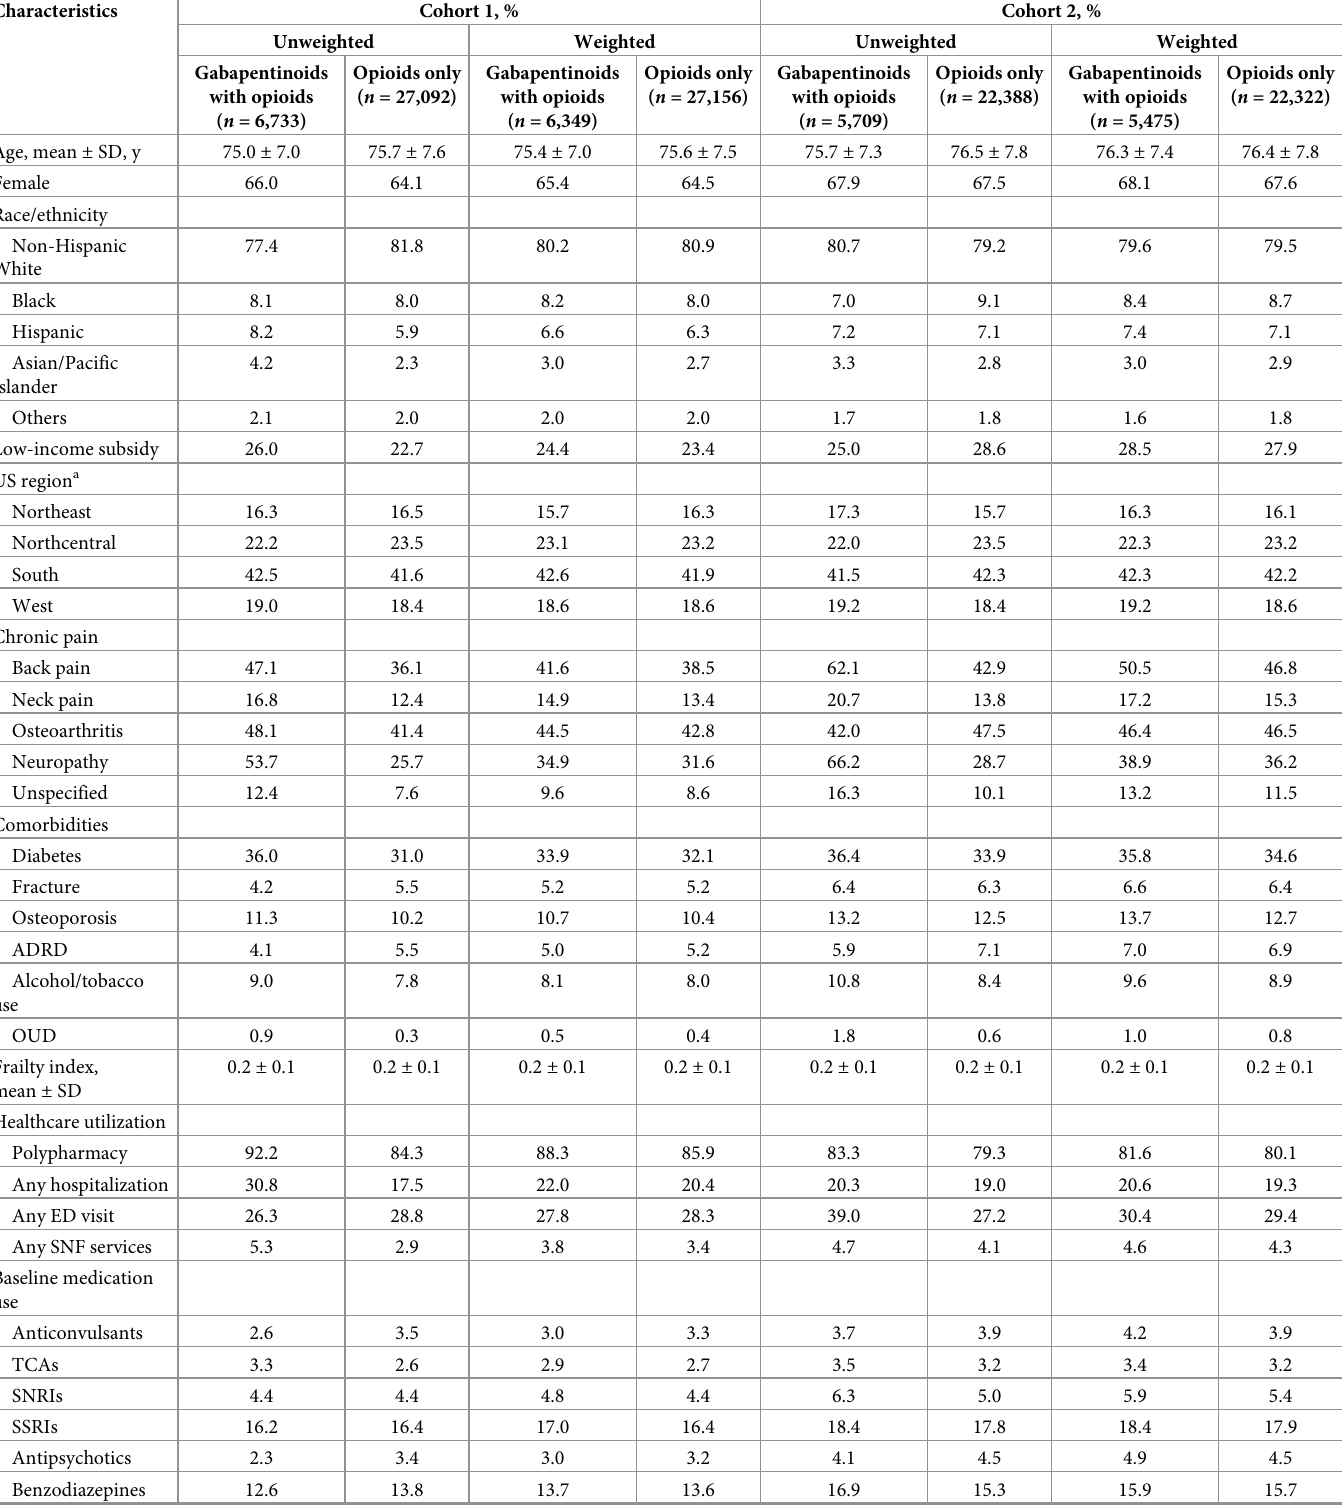
Table 1. Selected baseline characteristics of older adults with CNCP by treatment with concurrent use of gabapentinoids and opioids or opioids only.